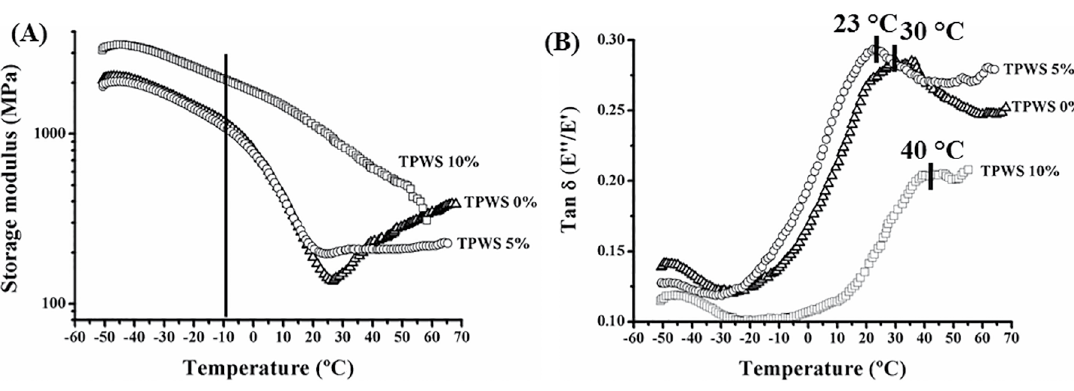
Figure 4. (a) Tensile storage modulus E′ versus temperature, and (b) Damping factor tan δ versus temperature for TPWS 0%, TPWS 5%, and TPWS 10% the decay for E' correspond to tan δ peak. The δ peak corresponded molecular relaxation or glass transition temperature (T ) of TPWS films that is affected by glycerol g and water